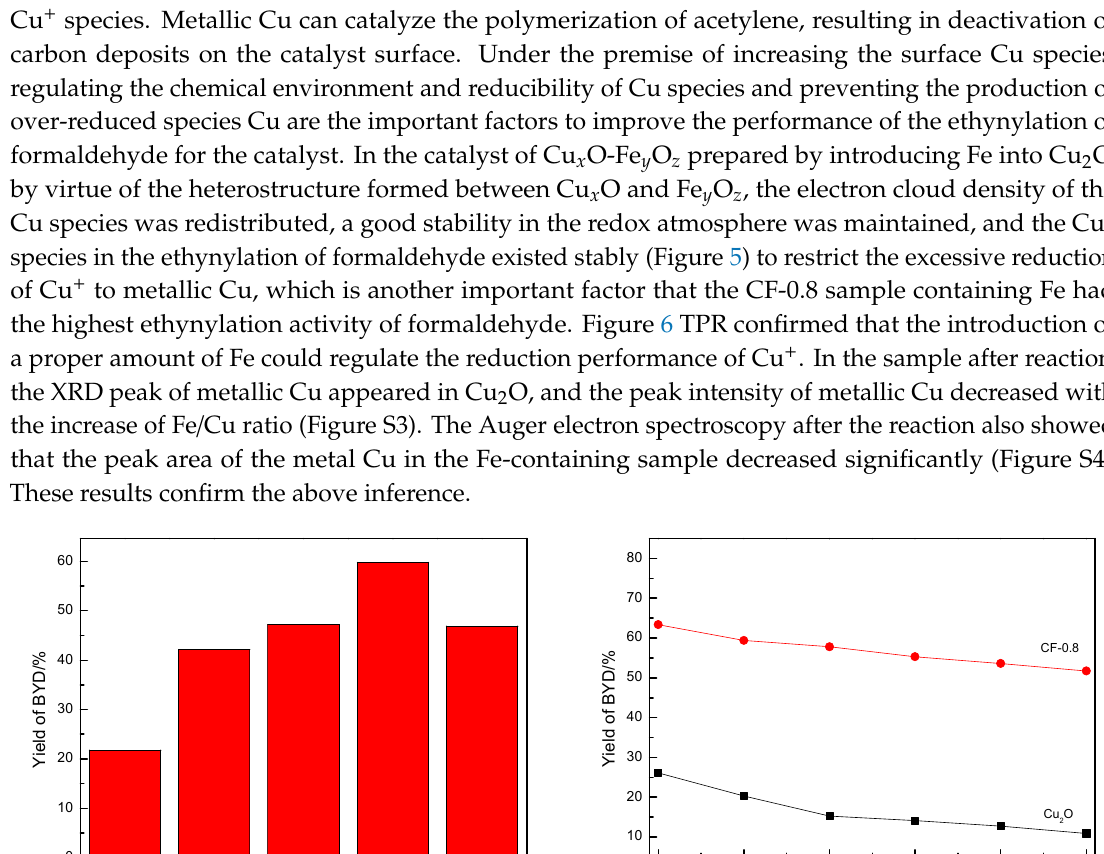
Figure S1: XPS spectra of Cu 2 O and Cu x O-Fe y O z with di ff erent Fe / Cu ratios, Table S1: Surface atomic ratios in